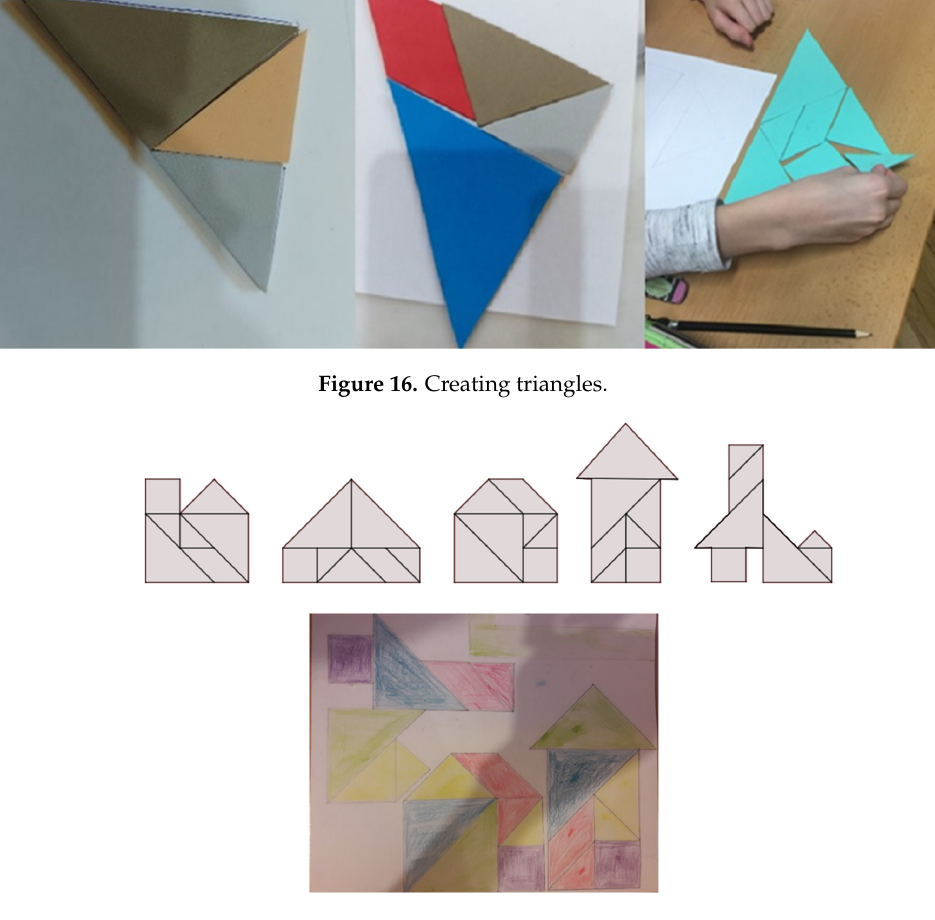
Figure 15. Quadrilaterals.